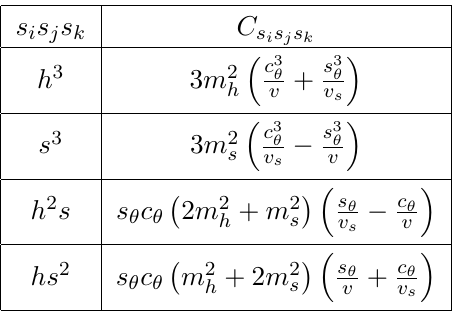
Table 2 . Trilinear couplings. Feynman rules are obtained by adding the multiplication factor ( (cid:0) i ). minimization conditions, one has (cid:22) 2